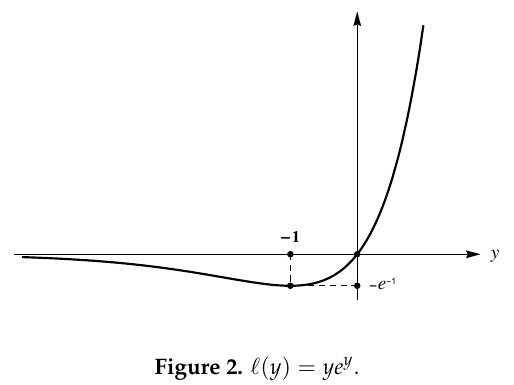
Figure 2. (cid:96) ( y ) = ye y